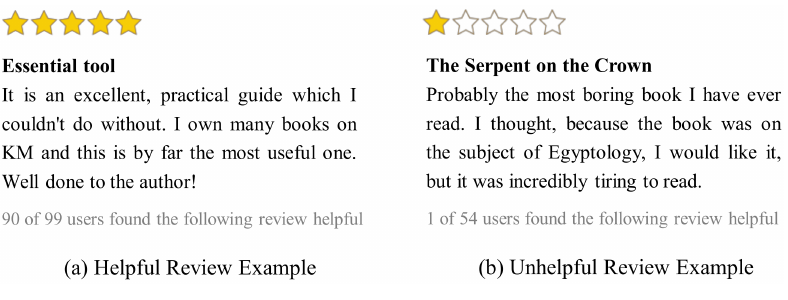
Figure 4. Examples of helpful reviews and unhelpful